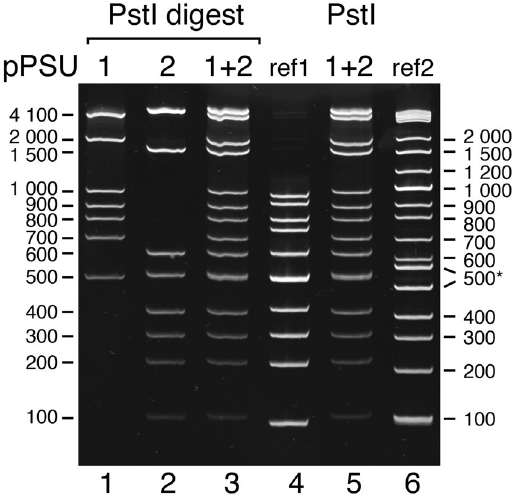
Figure 5. Penn State 100 bp ladder on a polyacrylamide gel (10% acrylamide). Lanes 1–3: PstI digests of pPSU1 and pPSU2 separately and combined to produce the standard Penn State 100 bp ladder. Lanes 4–6: The Penn State 100 bp ladder (lane 5) is compared to the Thermo Scientific Gene Ruler (lane 4, ref1) and NEB 2-log marker (lane 6, ref2). NEB 2-log marker contains 500 and 517 bp fragments to highlight the 500 bp band on agarose gels, but these fragments (marked with * ) separate significantly on the 10% acrylamide